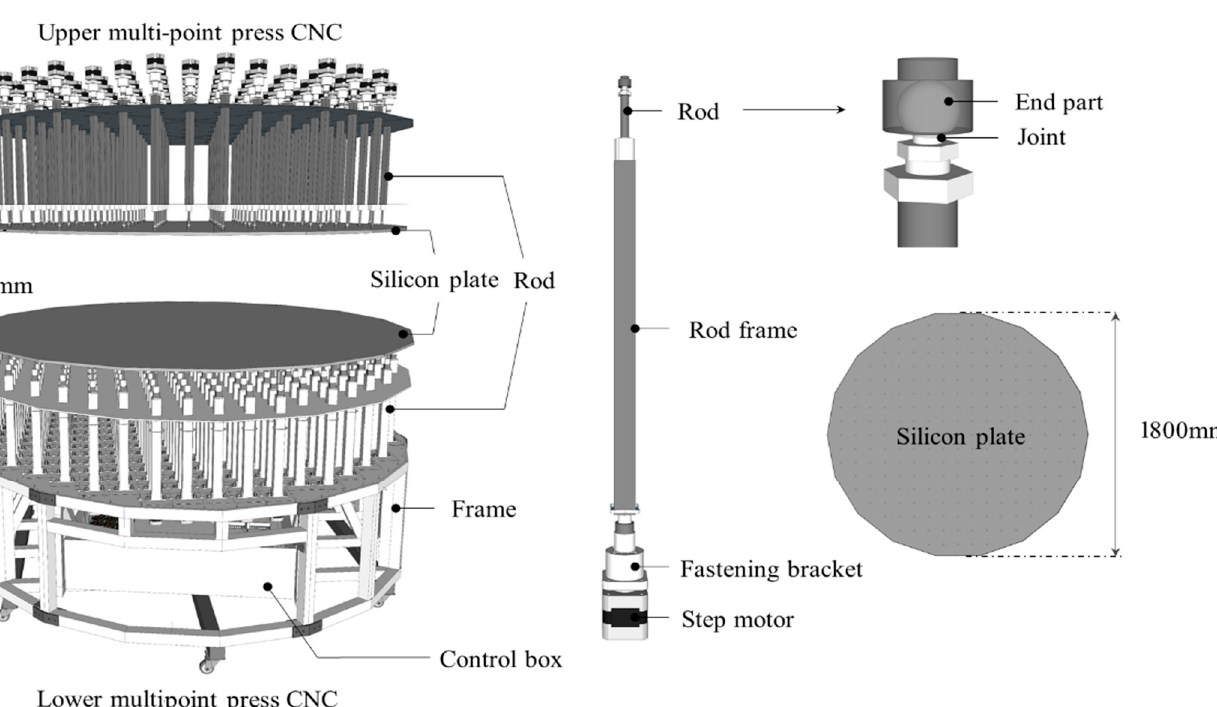
Figure 5. Composition of double-sided multipoint press equipment.